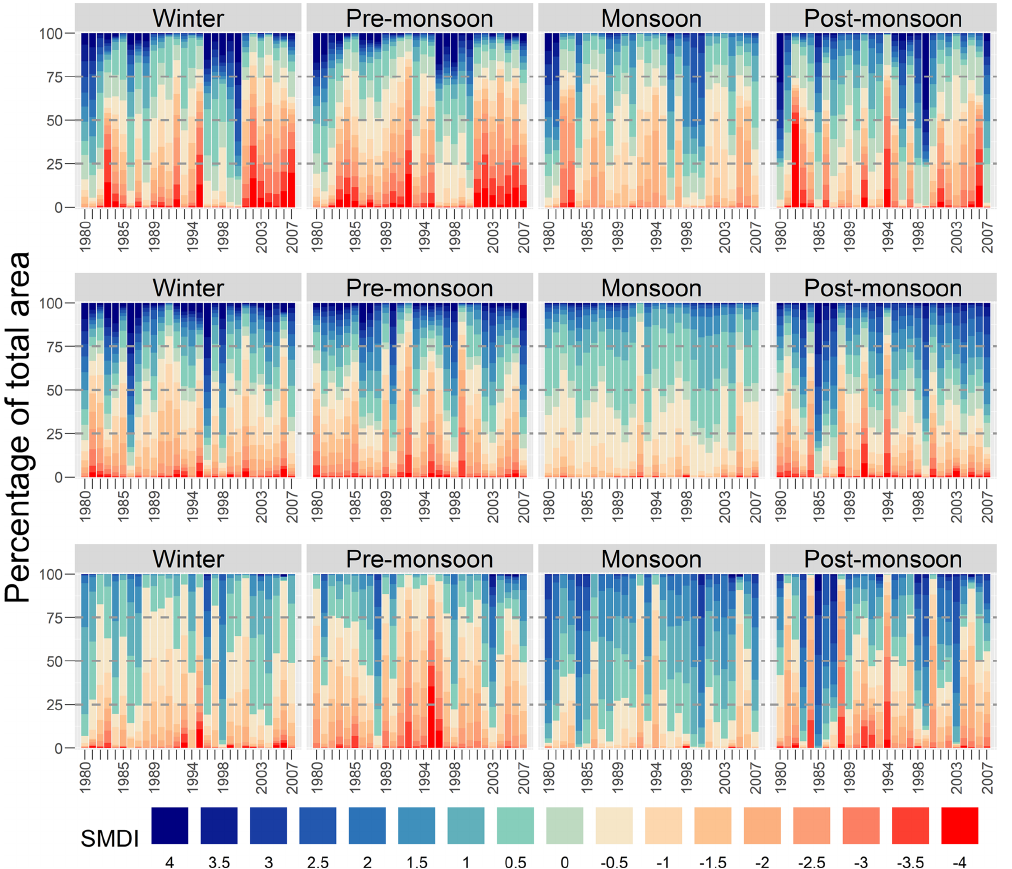
Figure 9. Spatial and seasonal variability in the SMDI in trans-Himalaya (top row), the mountains (middle row), and the plains (bottom row). Note: each colour band shows the respective HRU areas